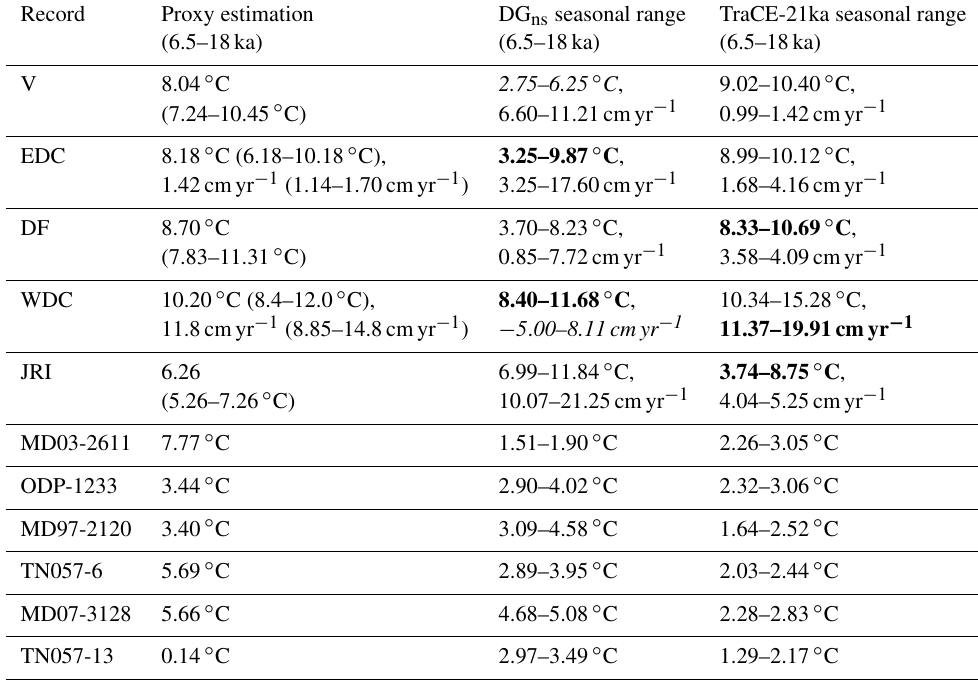
Table 3. Change from 18 to 6.5ka at Antarctic ice core sites (surface temperature, ◦ C; accumulation, cmyr − 1 ) and marine sediment core sites (SST, ◦ C) estimated in the proxy records and simulated in DG ns and TraCE-21ka for austral summer (December to February) and austral winter (June to August). Proxy records were linearly interpolated to 100-year averages. Bold font indicates a match between the seasonal range of change in the models and the proxy estimation at Antarctic ice core sites. Italic font indicates that the seasonal range of change in the model does not overlap the uncertainty range of the ice core record. We use uncertainties of + 30% to − 10% for V and DF temperature (Jouzel et al., 2003), ± 2 ◦ C for EDC temperature (Stenni et al., 2010), ± 1 . 8 ◦ C for WDC temperature (Cuffey et al., 2016), and ± 1 . 0 ◦ C for JRI temperature (Mulvaney et al., 2012). For accumulation, we assume uncertainties of ± 25% (Fudge et al., 2016). Record Proxy estimation DG ns seasonal